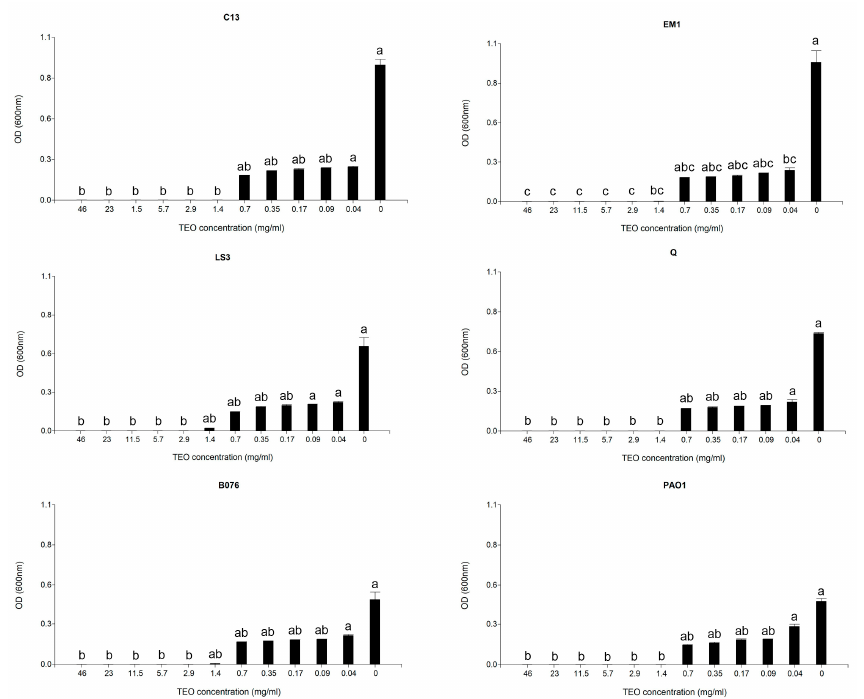
Figure 3. Growth of sessile cells within a bio fi lm in the presence of TEO (OD 600 nm), as observed in the phytopatogenic strains P. syringae C13, P. syringae EM1, P. syringae LS3, P. syringae Q, P. savastanoi pv. glycinea BO76, and P. aeruginosa PAO1. The results are expressed as the mean ± standard error (SEM) of OD measured at 600 nm. Means with different letters indicate statistically significant differences ( p < 0.05). Lowercase letters compare the control (0 mg/mL) and the strains treated with di ff erent concentrations of TEO.